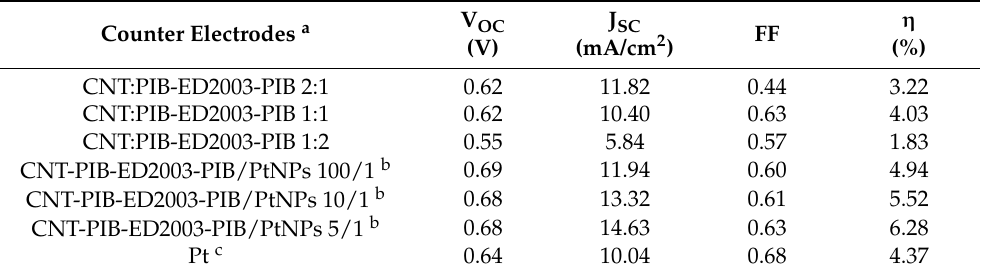
Table 2. Efficiencies of the counter electrodes made of dispersant/CNT at different weight ratios and CNT/PtNPs at different ratios without FTO substrate.